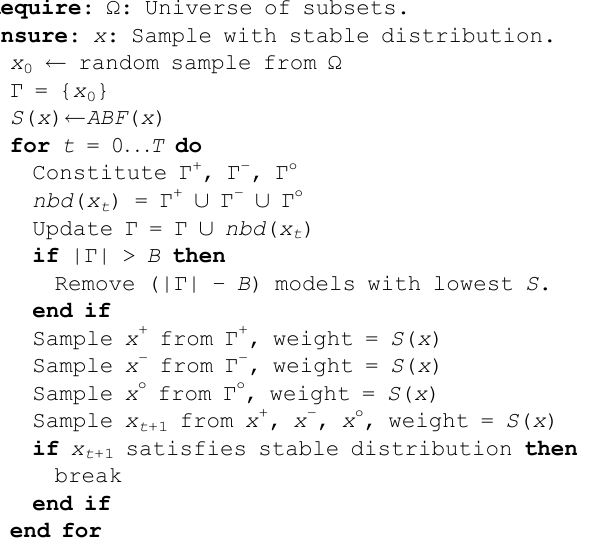
Algorithm 2 SSS